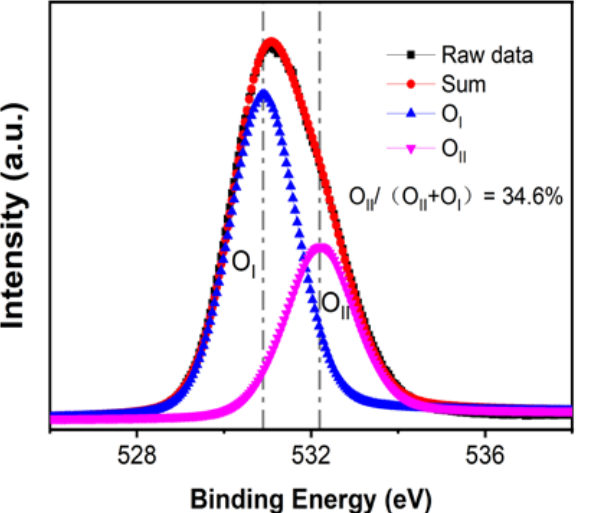
Figure 2. The x-ray photoelectron spectroscopy (XPS) O1s spectrum of the AlO x EDL thin film. Figure 2. The X-ray photoelectron spectroscopy (XPS) O1s spectrum of the AlO x EDL thin